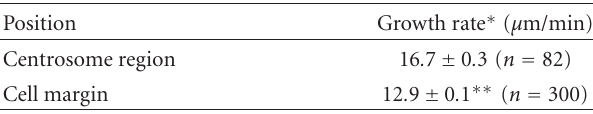
Table 2: Microtubule plus ends growth rate in di ff erent areas of human EC.